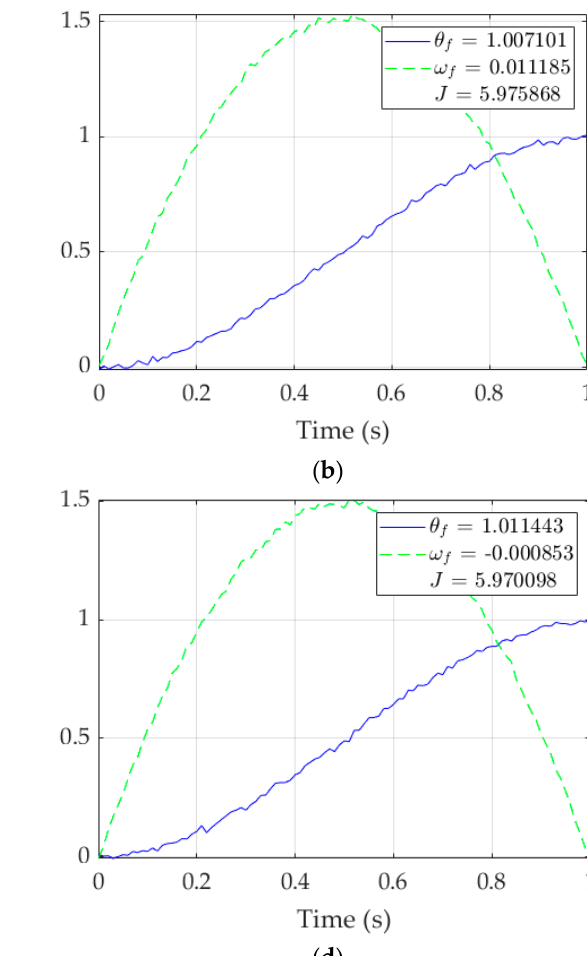
Figure 5. Singular run of RTOC using pinv ( A ) without open-loop switching. Note the deterioration in 𝜔(𝑡) starting after time = 0.8 s, indicating the function’s inability to reliably solve the system as it approaches singularity.